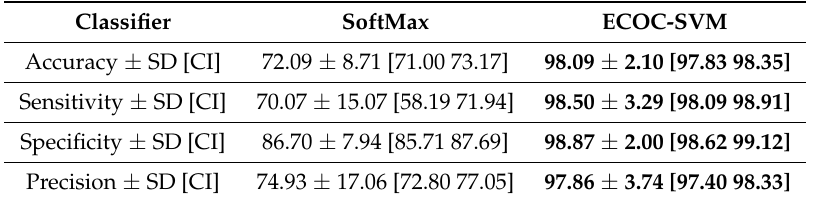
Table 7. Accuracy, Sensitivity, Specificity and Precision for Different Classifier Using LSTM. (The Numbers in Bold Indicate the Best Value Obtained for Each Quality